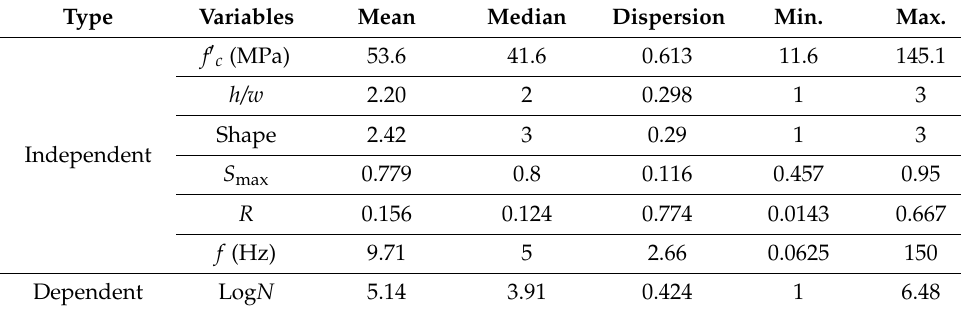
Table 3. Statistical feature average data excluding outliers.